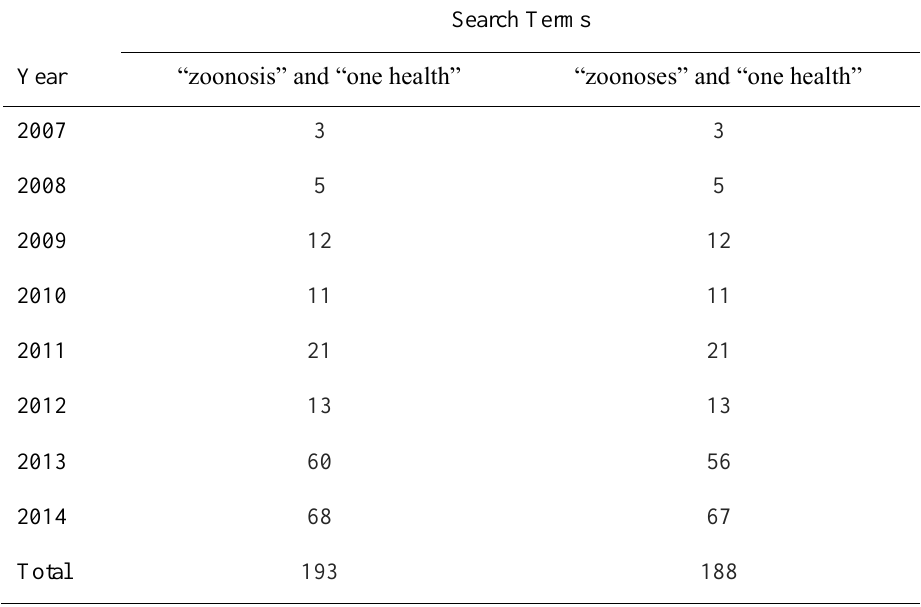
Table 2: Frequency of articles from January 2007 to December 2014 for advanced search terms in